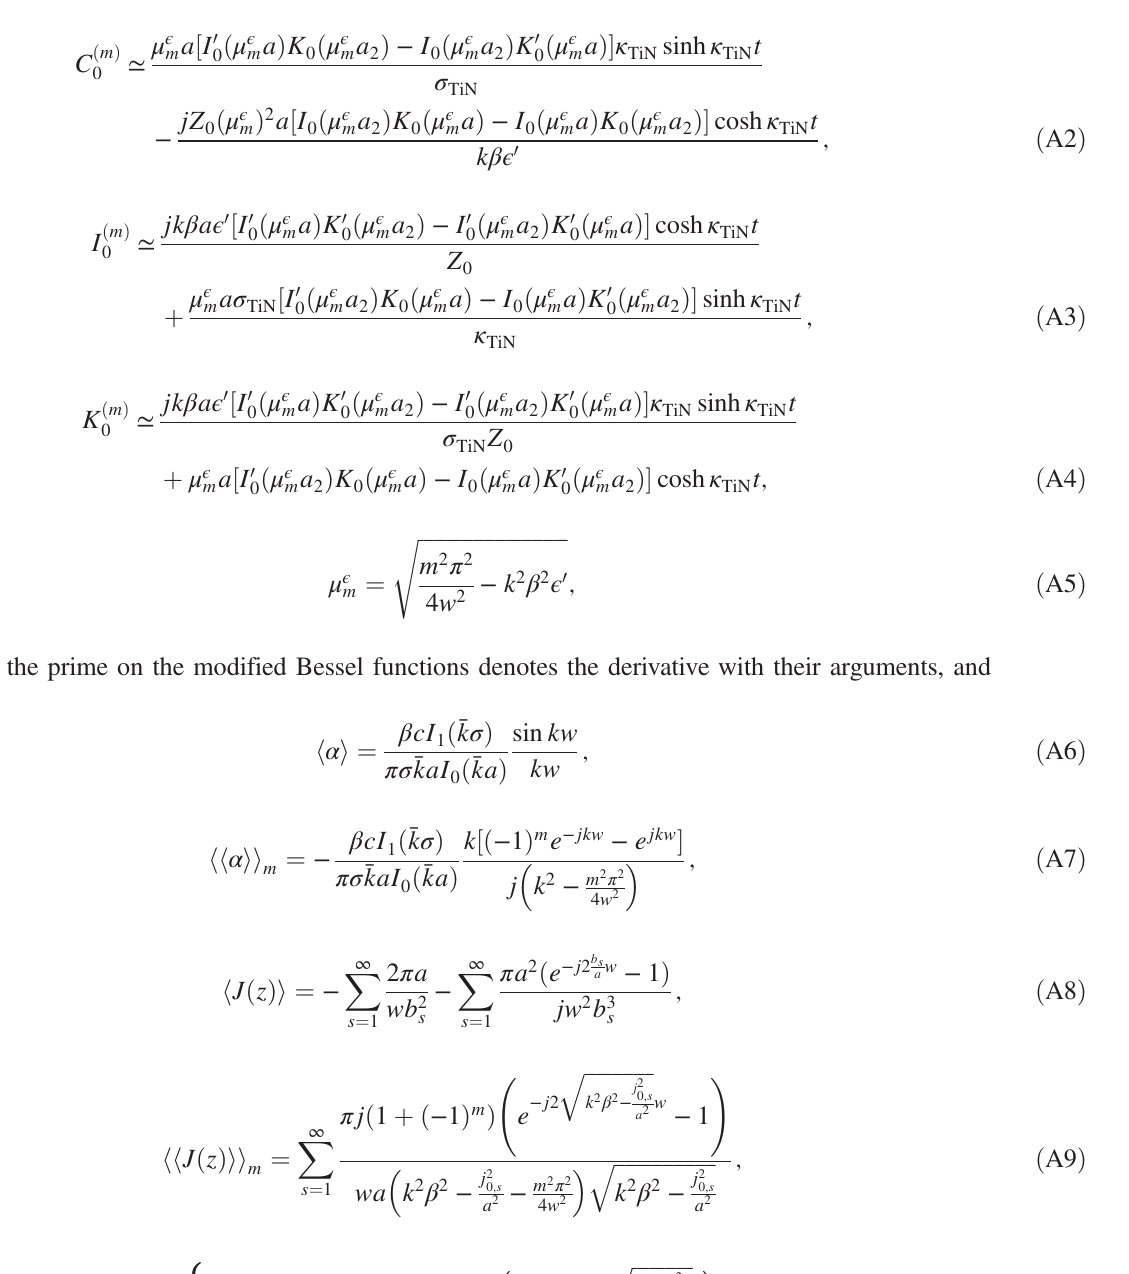
ffiffiffiffiffiffiffiffiffiffiffiffi